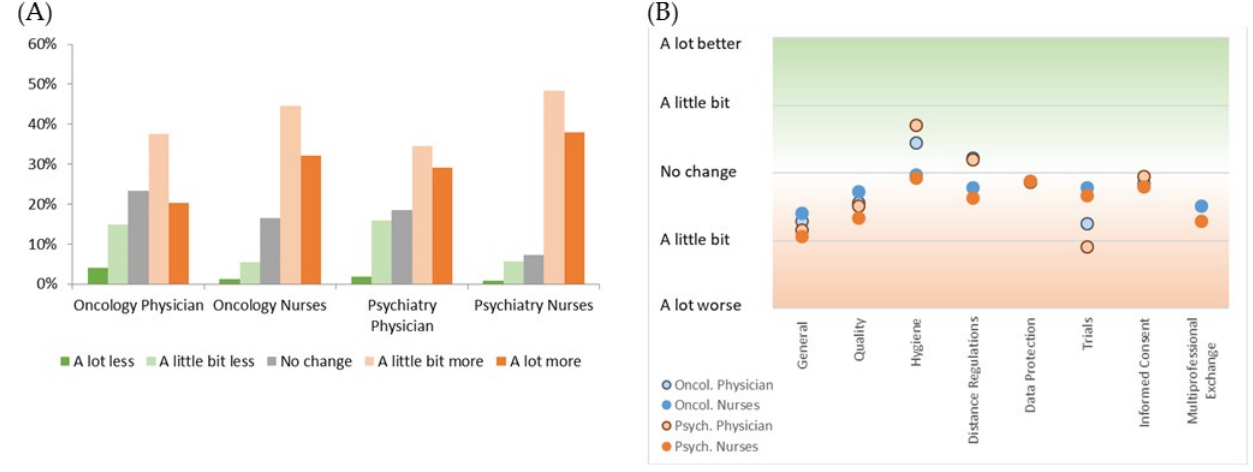
Figure 1. ( A ) Reflected alteration of the workload by healthcare professionals; and ( B ) their perception of changes in clinical management due to pandemic conditions.